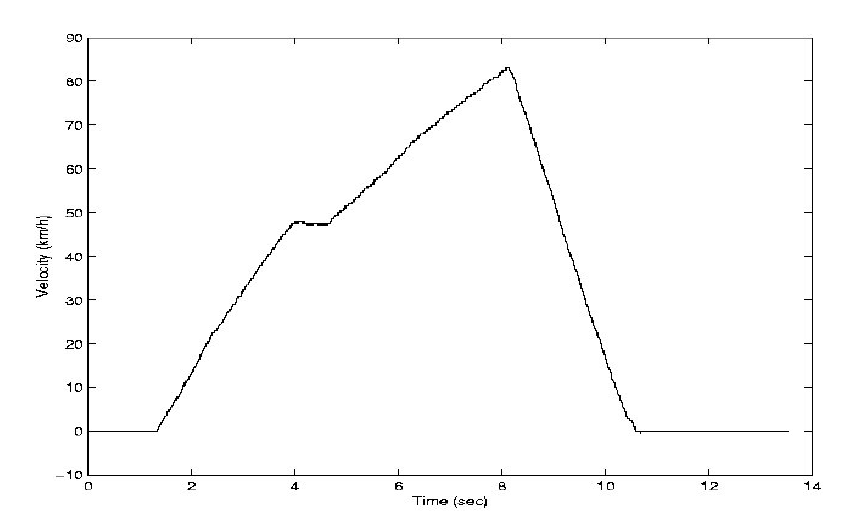
Figure 6. Velocity (km/h) vs. Time